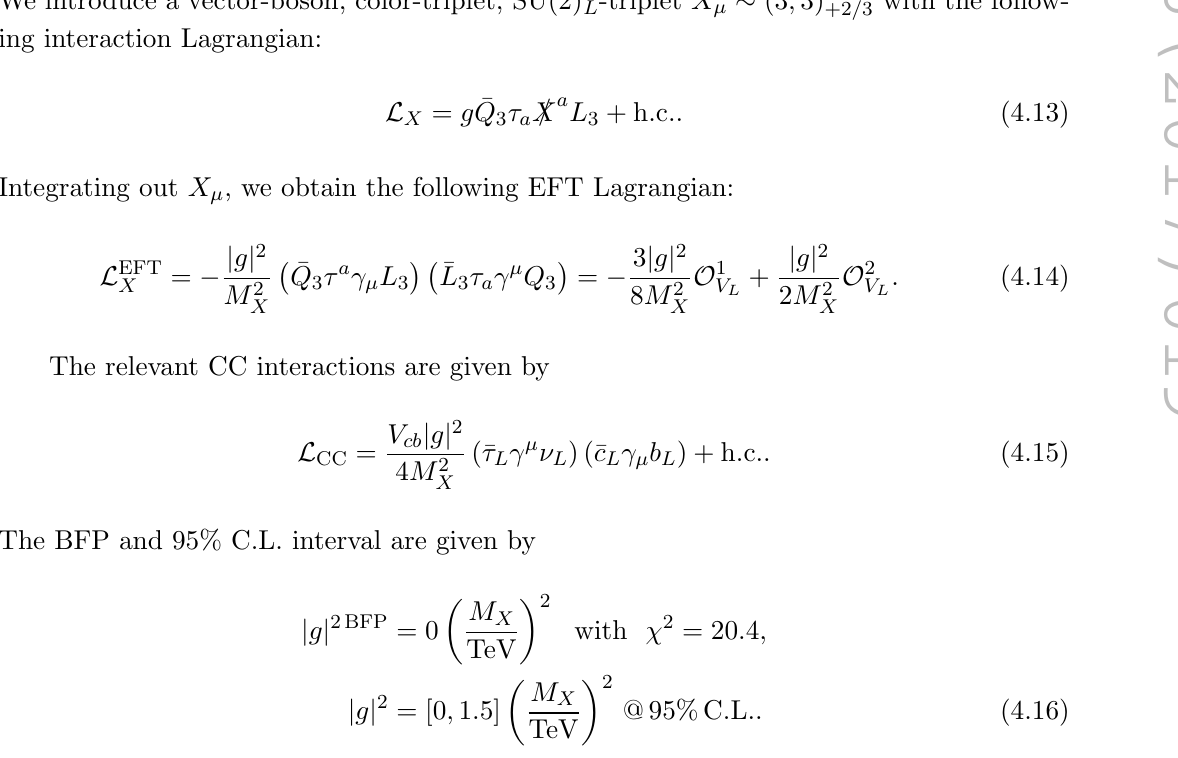
(cid:24) (3 ; 3) (cid:22)